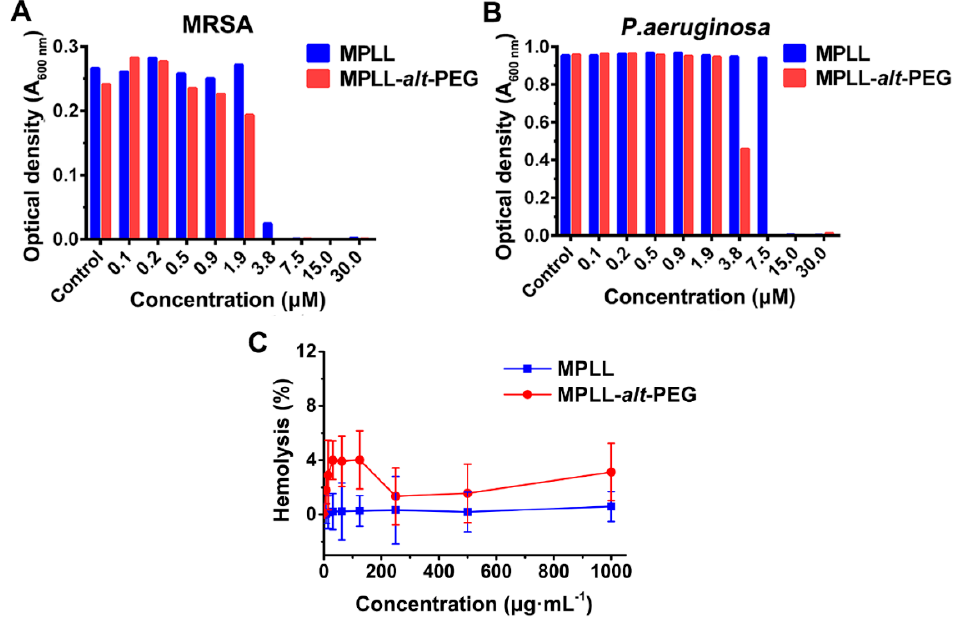
Figure 5. Optical density of MRSA ( A ) and P. aeruginosa ( B ) in MHB after incubation with various concentrations of MPLL and MPLL- alt -PEG copolymers for 18 h; ( C ) hemolysis of MPLL and MPLL- alt -PEG copolymers. MRSA: methicillin-resistant Staphylococcus aureus ; MHB: Mueller Hinton Broth.